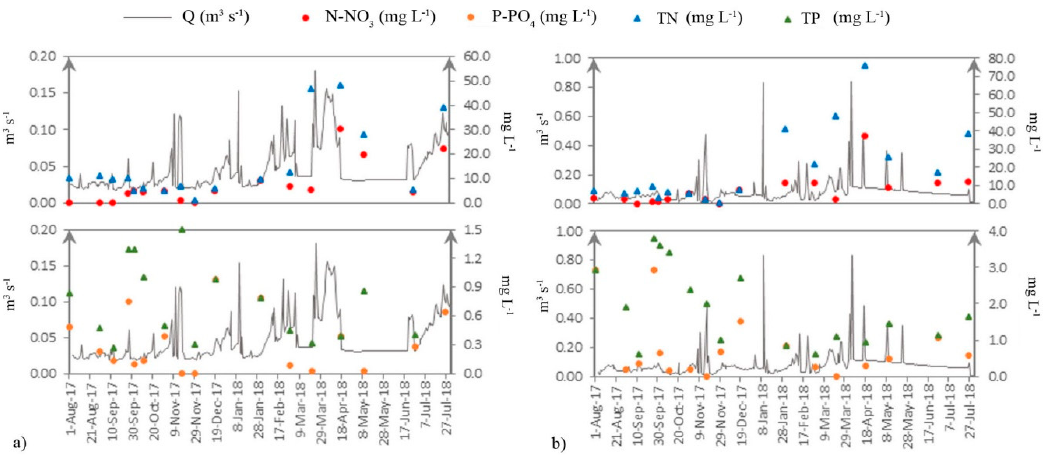
Figure 3. Streamflow and nutrients concentrations (TN, N-NO 3 , TP, P-PO 4 ) measured at gauges A ( a ) and B ( b ).